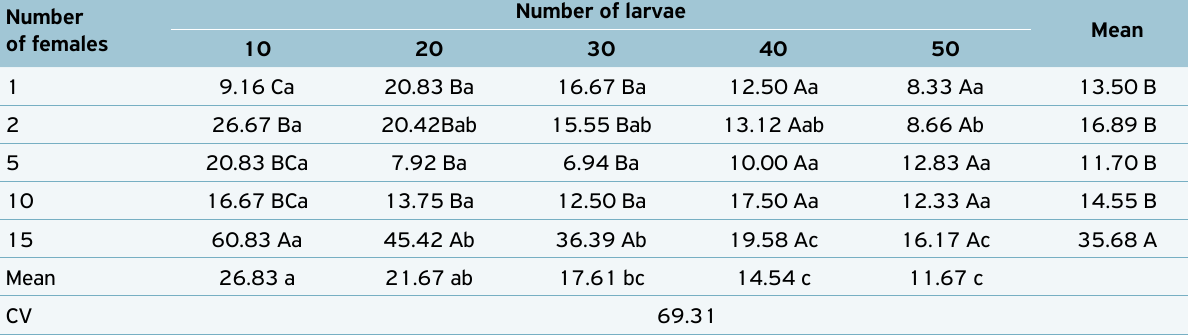
1 Different letters mean significance between the means, in the lines (lower case) and columns (upper case) (p<0.05); CV: coefficient of variation.